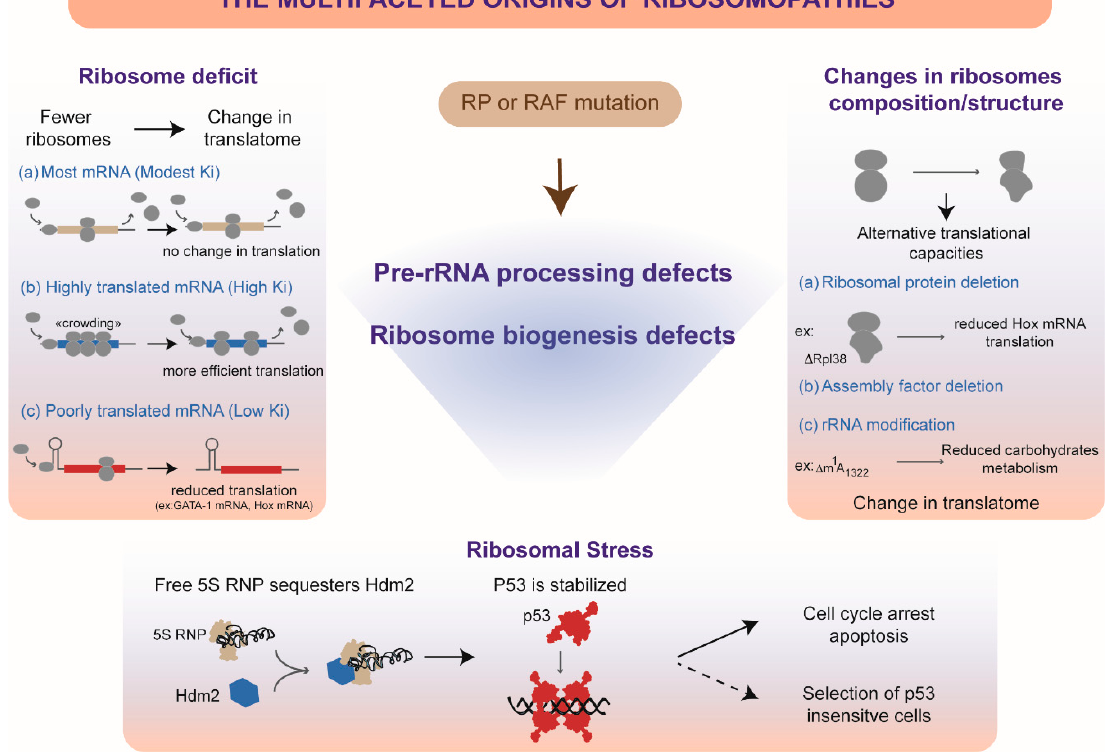
Figure 5. The molecular effects of mutations affecting pre-rRNA processing and ribosome assembly. Mutations in genes encoding RPs or RAFs can lead to pre-rRNA processing or ribosome assembly defects. In human cells, different hypotheses may explain how these defects affect cell fate. Ribosome deficit corresponds to reduction in the number/concentration of ribosomes per